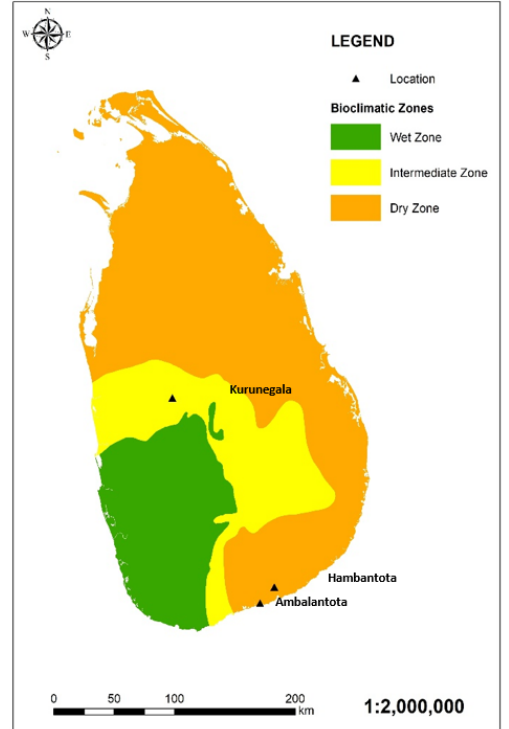
Figure 1: Locations of sample collection: Hambantota, Kurunegala and Ambalantota.